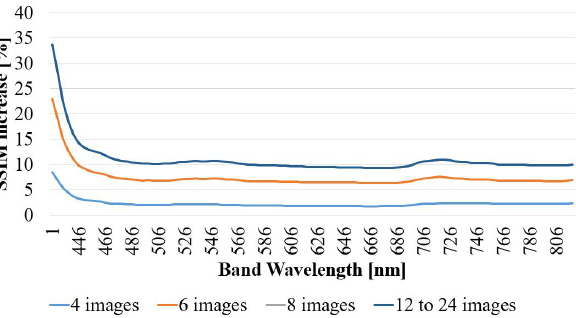
Figure 11. Performance variation of the algorithm for SSIM metric, varying the number of integrated images (N). Performances for N = 8, 12, 16, 20 and 24 are superposed in the figure for being extremely similar. Sequence 1 , EF =